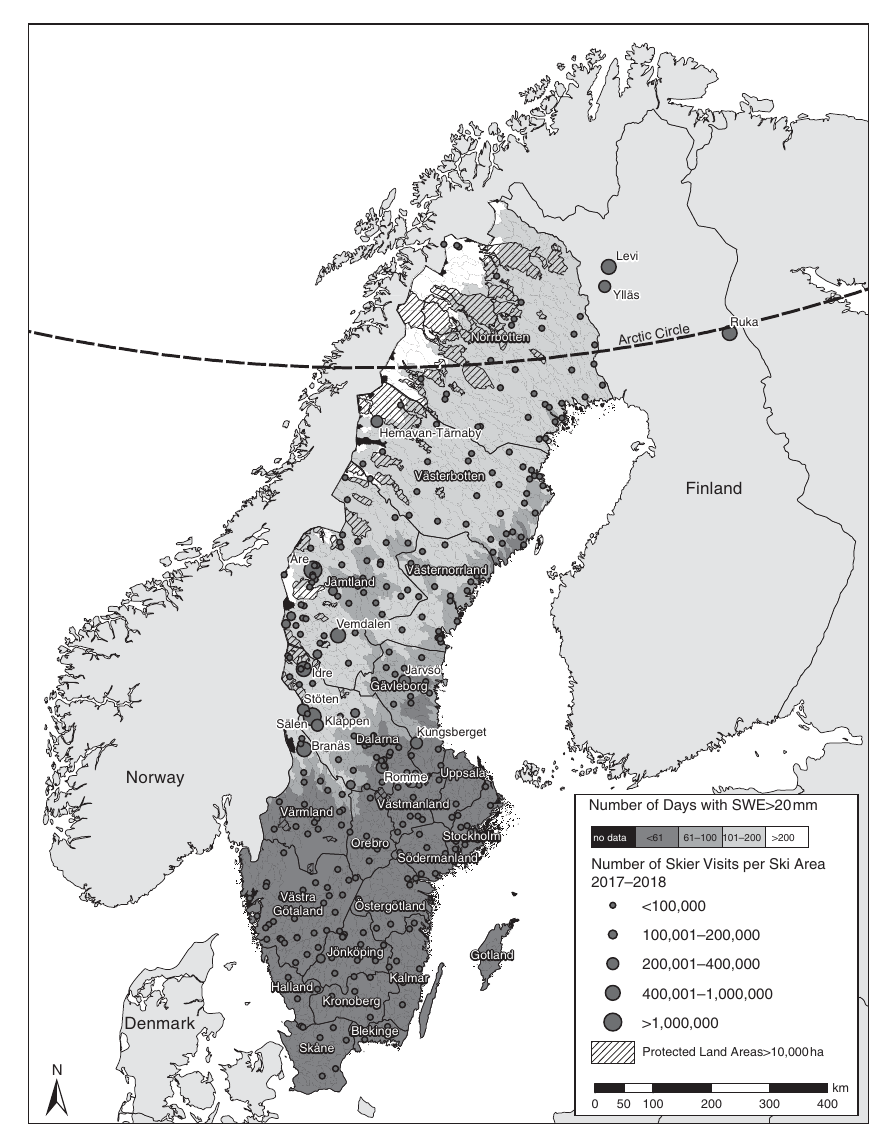
Figure 2 Snow reliability of downhill skiing areas in Sweden 2021 – 2050